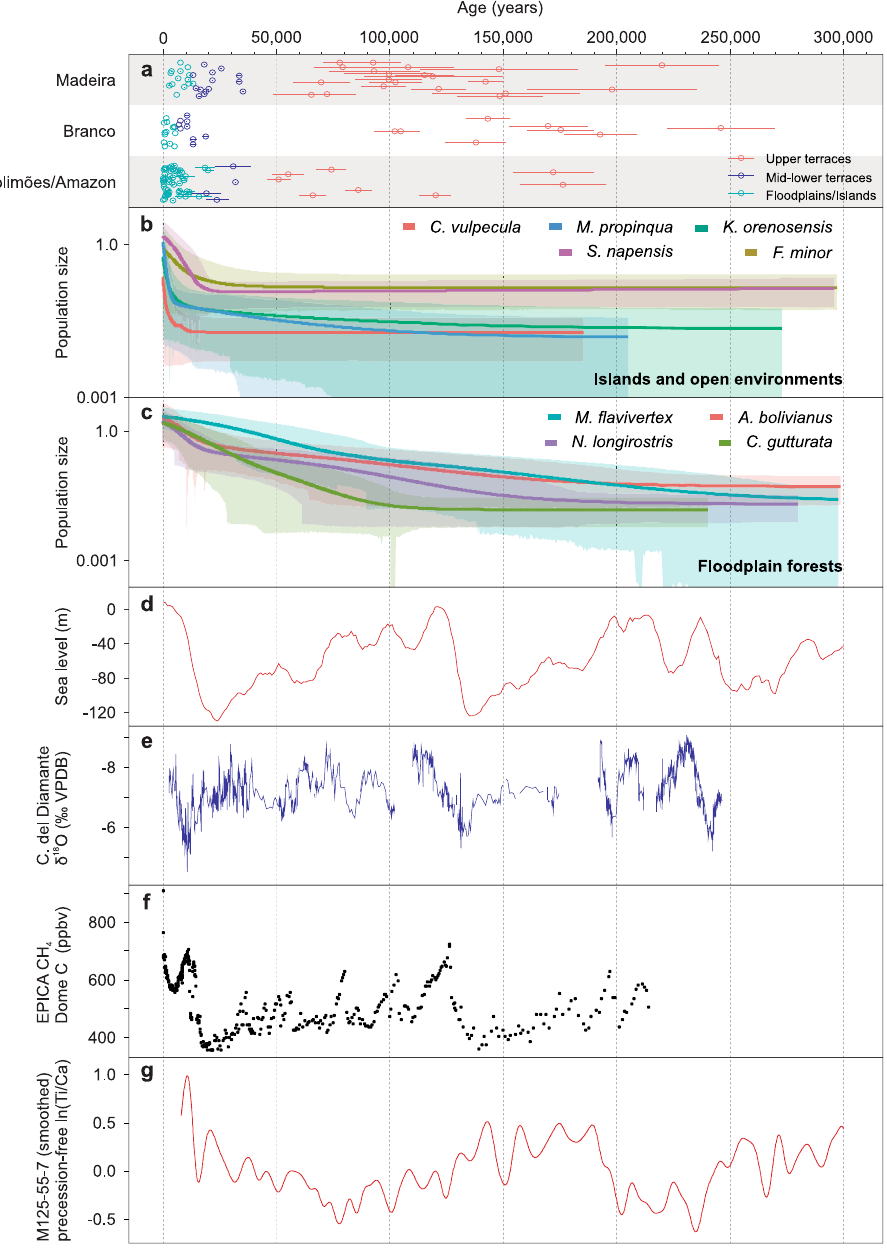
Fig. 8 | Summary of results (last 300ka). OSL and radiocarbon ages from fl ood- plains/islands and fl uvial terraces ( a ) are compared to plots showing population sizes through time estimated in the EBSP analyses for bird species specialized in islands or riverbanks ( b ), and for bird species specialized in fl oodplain forests ( c ), sea level variation derived from benthic foraminifera δ 18 O stack from globally dis- tributed marine sites ( d ), precipitation variation in western Amazonia ( e ), atmo- sphere methane (CH 4 ) concentration ( f ) and precession-free variation of titanium- to-calcium ratio (ln(Ti/Ca)) in marine sediments (core M125-55-7) offshore eastern Brazil ( g ). Data generated in this study ( a , b , c ) are presented in Supplementary Information. In panel a , dots represent sediment sample ages and horizontal bars representageerrorscalculatedaccordingtotheGaussianlawoferrorpropagation.